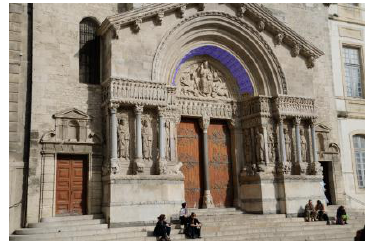
Figure 14: Visualisation of the area on another image In this process, the transfer can be performed in two ways for an image: from the picture (definition of an annotation) or to the picture (transfer from another picture ).